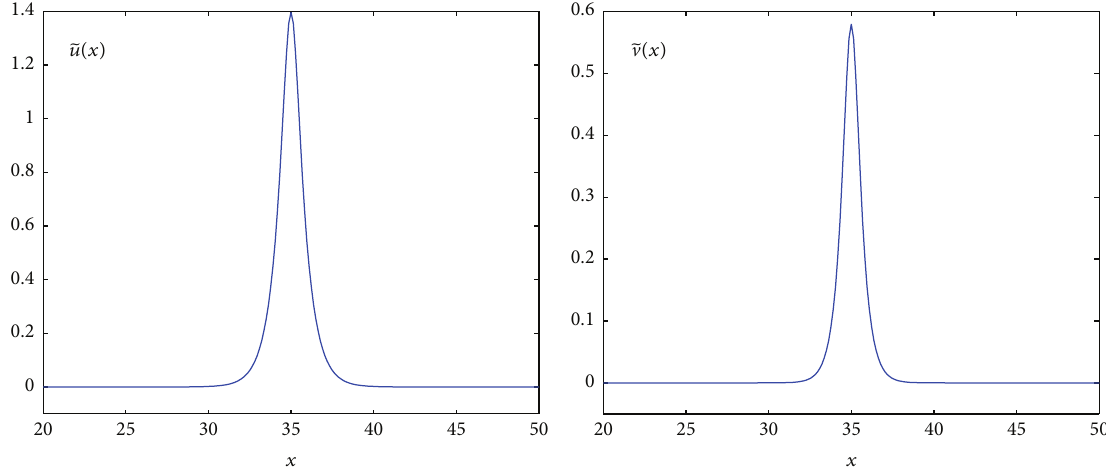
Figure 1: Vector soliton of system (1) obtained after 10 Newton’s iterations and 𝛿 = 0 , 𝜎 1 = 0.5 , 𝜎 2 = −0.5 , 𝛼 = 1.5 , and 𝐾 = 0.5 .